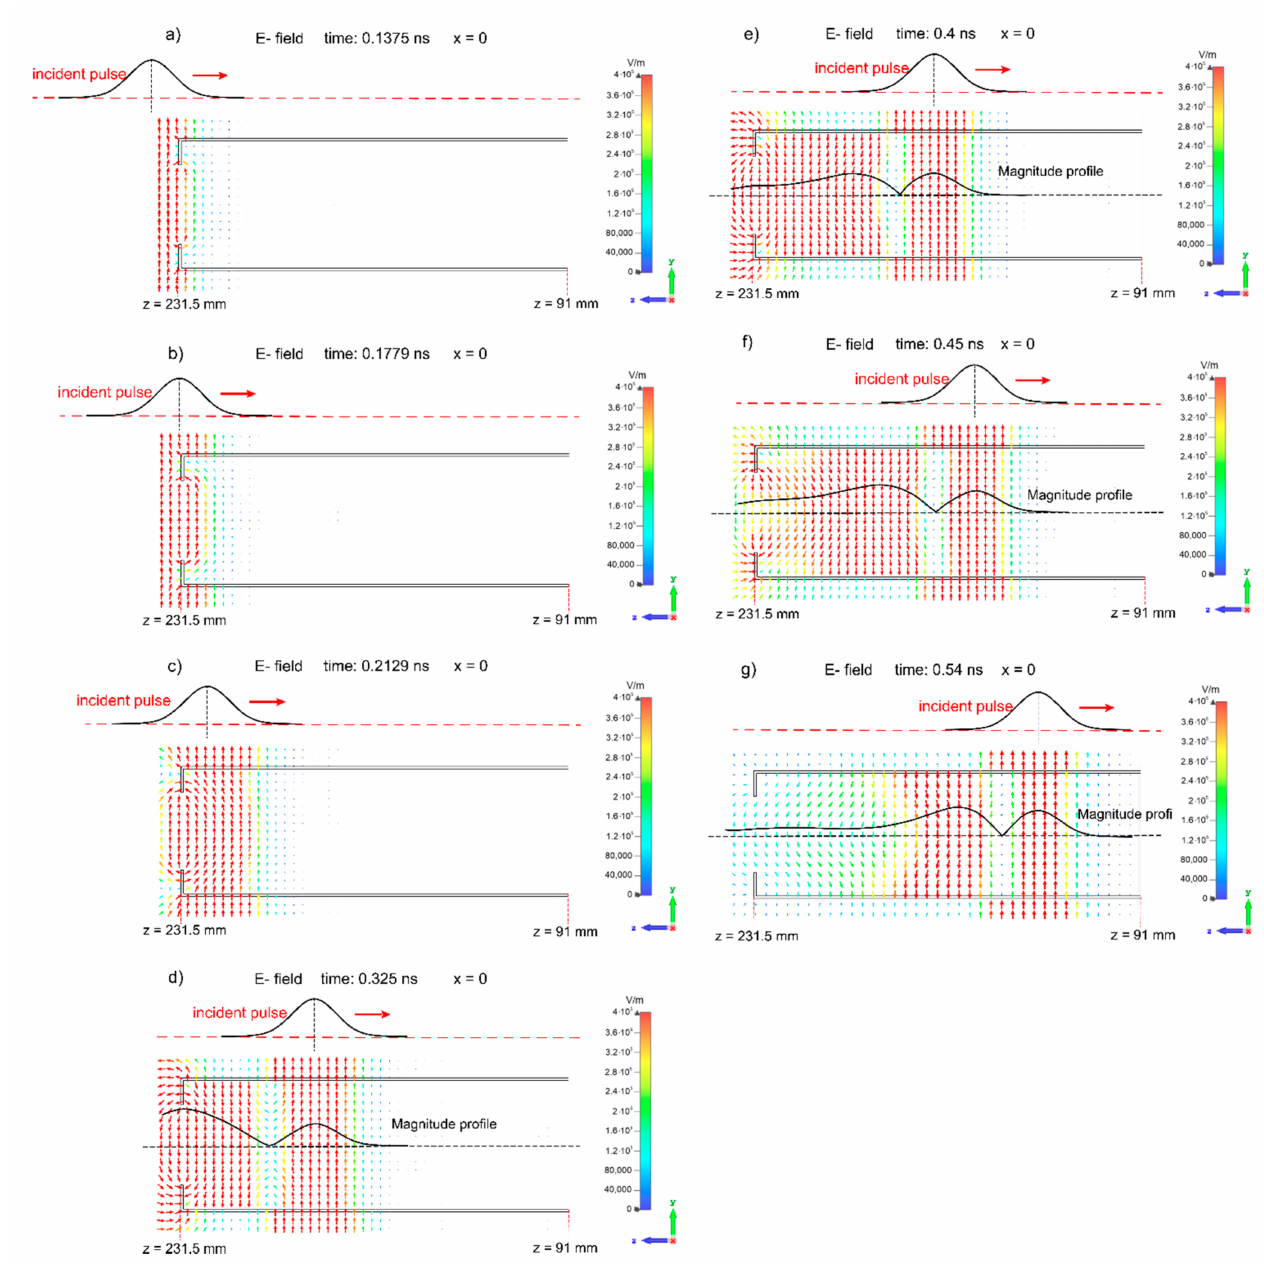
Figure 5. Vector maps of the electric field distribution in the plane x = 0 for various times (at t = 0 the incident plane wave pulse onset reached the front plane of the enclosure). ( a ) t = 0.1375 ns (the half-maximum of the front part of the incident pulse passed the enclosure front plane), ( b ) t = 0.1779 ns (the incident pulse maximum passed the enclosure front plane), ( c ) t = 0.2129 ns (the half-maximum of the rear part of the incident pulse passed the enclosure front plane), ( d ) t = 0.325 ns (the incident pulse fully passed the enclosure front plane), ( e ) t = 0.4 ns, f ) t = 0.45 ns, and g ) t = 0.54 ns—the incident pulse continued to move away from the enclosure front